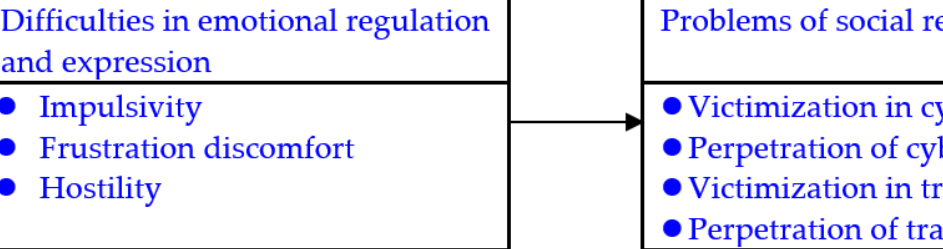
Figure 1. Hypothetical frame of this study.